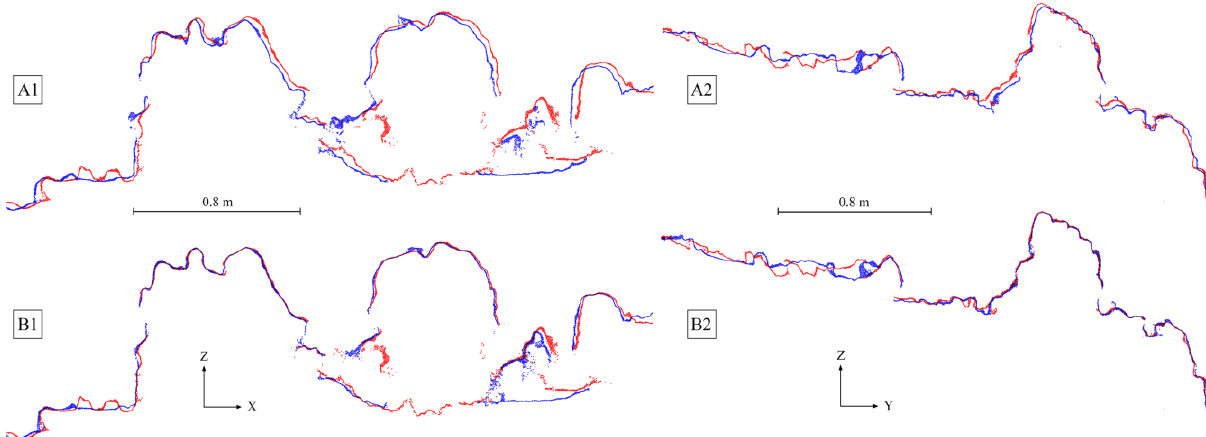
Fig.8: Two profiles (locations are given in Figure 7) with extracted points for the January (blue) and August (red) point clouds. The thicknesses of the profiles are 1 cm each. Profile 1 is along the x-axis before (A1) and after (B1) the ICP registration. Profile 2 is parallel to the y-axis before (A2) and after (B2) the ICP registration. Note the obvious systematic shift that has vanished after the ICP registration.